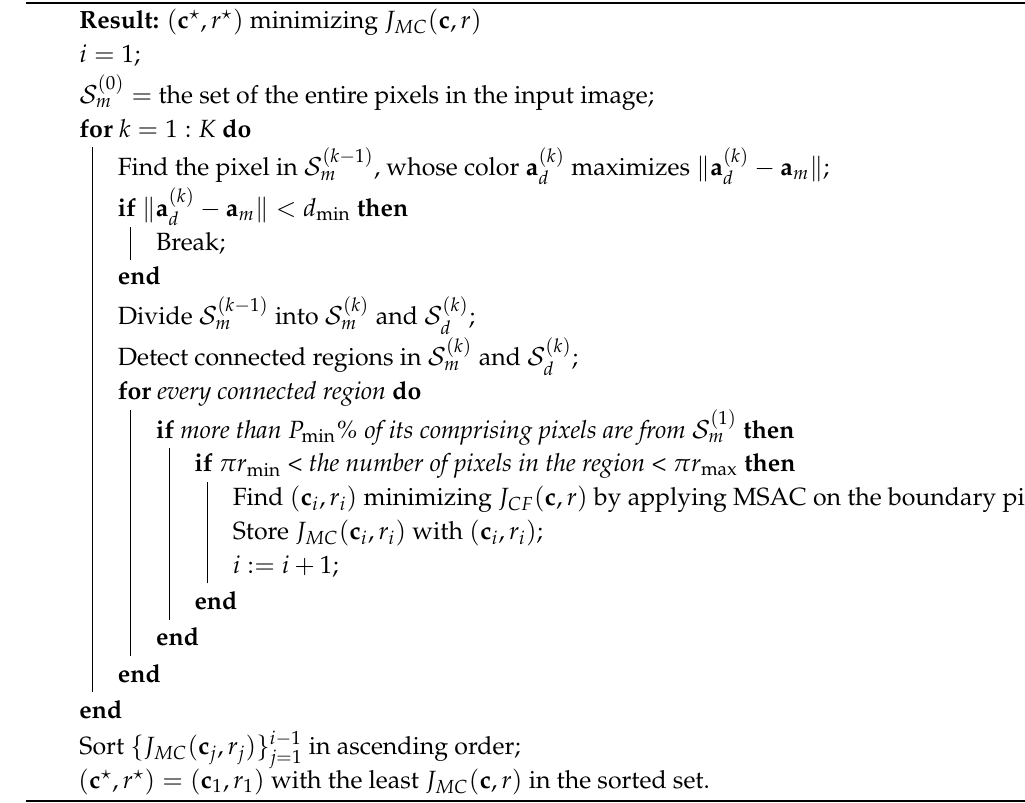
Algorithm 2: Proposed circle detection